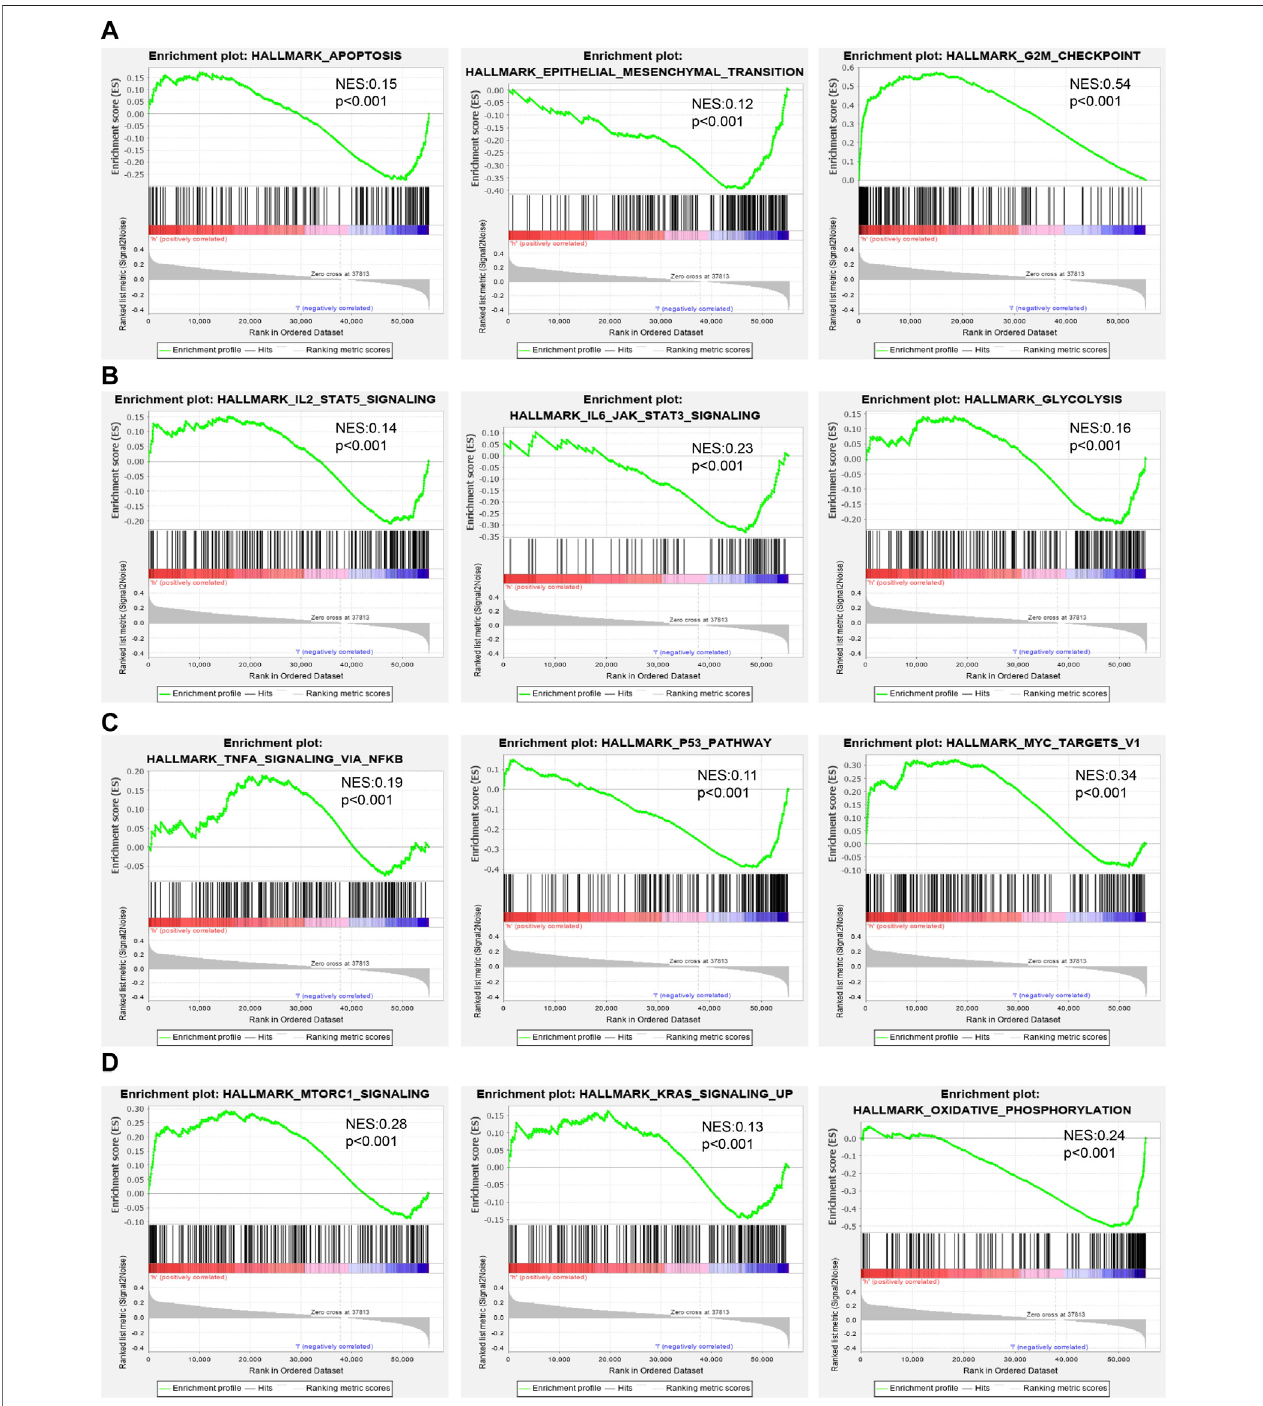
FIGURE 7 | GSEA identi fi cation of AC087588.2-related signaling pathways. (A – D) Identi fi cation of AC087588.2-related signaling pathways by GSEA software.